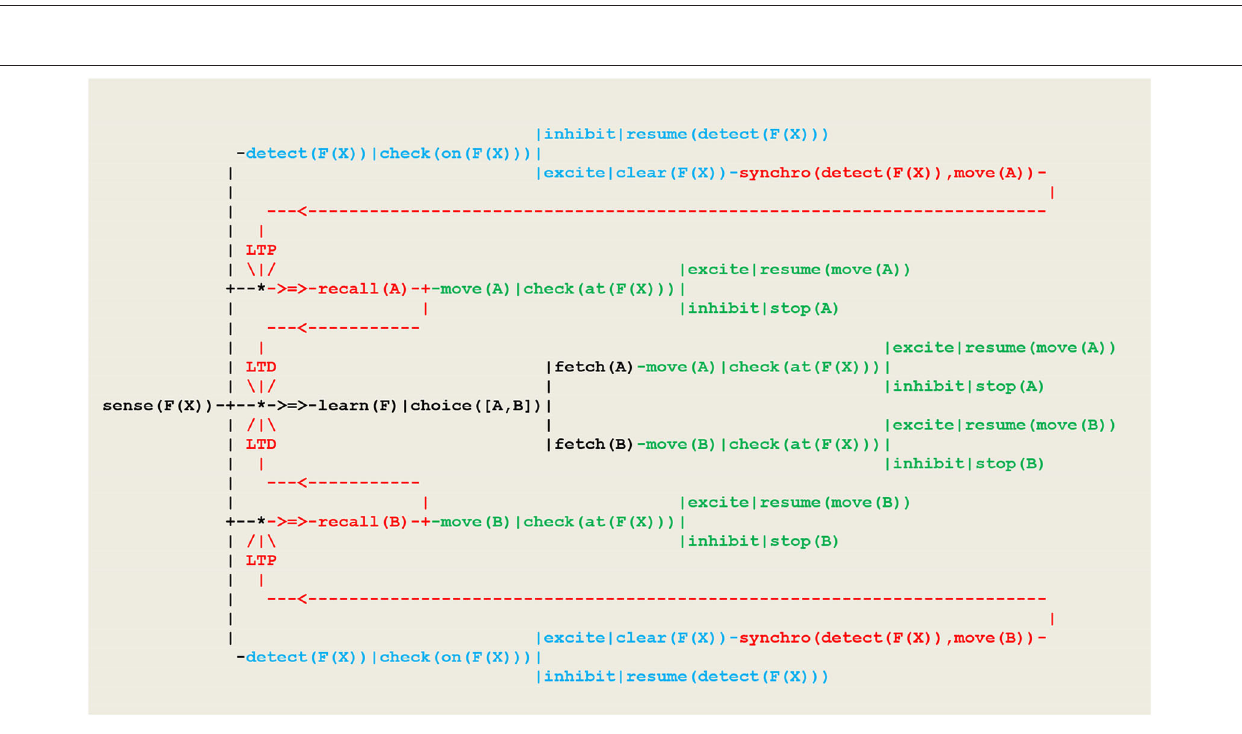
FIGURE 13 | Circuit implementing a deterministic behavior. Let Y represent A or B . The ltp/ltd threads are activated via recall(Y) threads by synchronization threads synchro(detect(F(X)),move(Y)) , which themselves fire whenever the tests check(on(F(X))) in detect(F(X)) and check(at(F(X))) in move(Y) provide a simultaneous excite